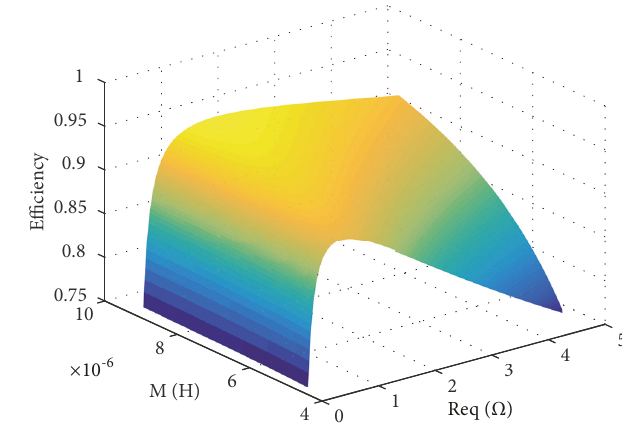
Figure 6: Efficiency varies with mutual inductance and